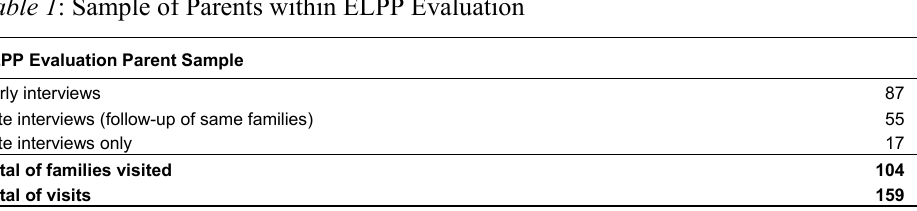
Table 1 : Sample of Parents within ELPP Evaluation